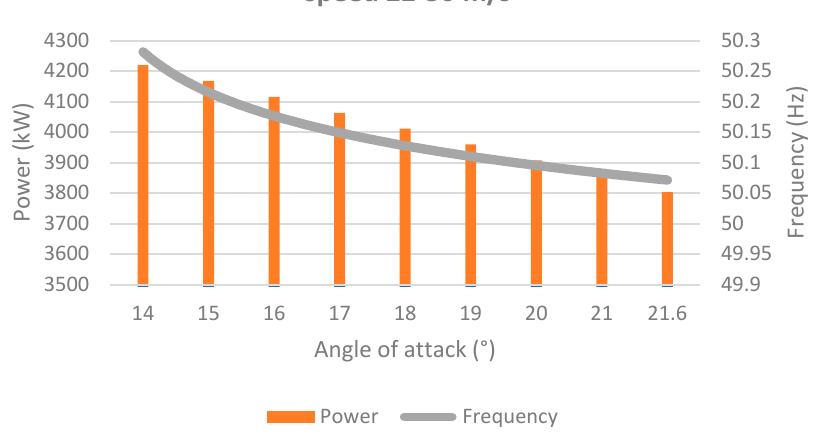
Figure 11. Graphical dependence of power regulation–reduction [source: author’s archive] .